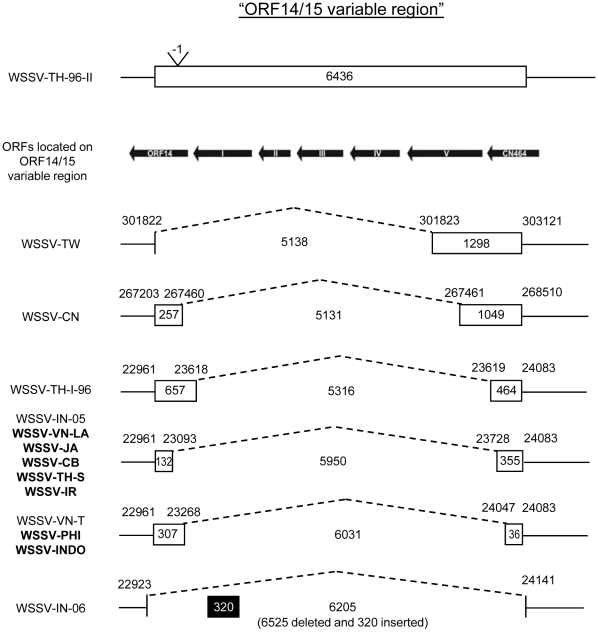
Schematic representation of the ORF14/15 variable region of the Asian WSSV isolates.Names of WSSV isolates characterized in this study are in bold. The coordinates of the WSSV-Asian isolates are given according to the WSSV TH-96-II annotation [8]. The length of the fragments is indicated within boxes or sequences. WSSV IN-06 has an inserted sequence, which is marked with a black box.